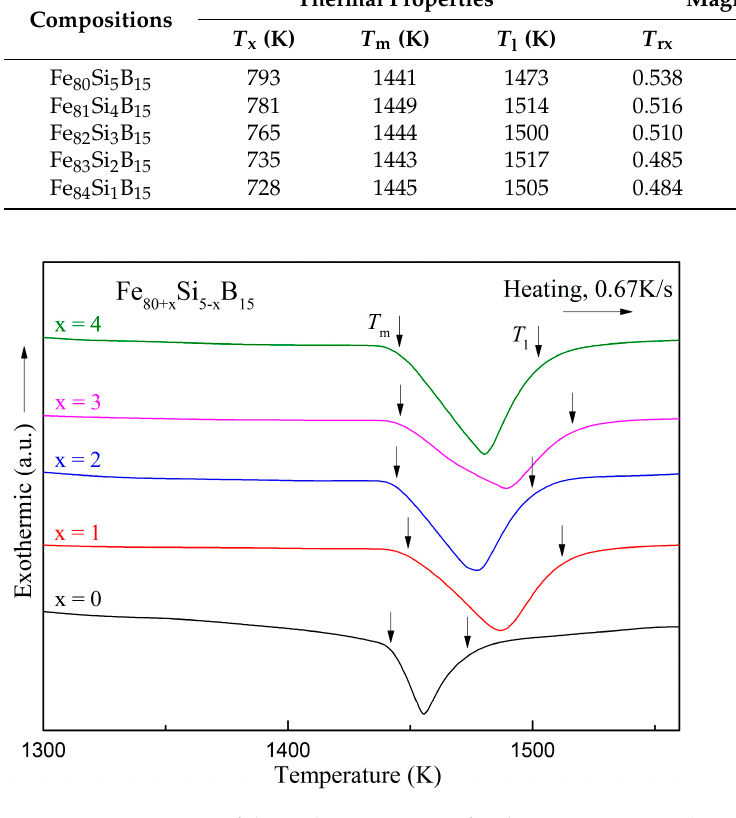
Figure 8. Changes in T rx and H c of the Fe 80+x Si 5 − x B 15 ( x = 0–4) amorphous alloys. The magnetic properties of these glassy alloys were further investigated. The hyste- resis loops of the as-quenched ribbons are presented in Figure 9a. Three individual amor- phous alloy ribbons of each composition, which were prepared at a linear velocity of 35 m/s and polished, were selected for the VSM test to improve the reliability of the data. All samples exhibited the typical loops of soft magnetic amorphous alloys. The B s values were derived from the density ρ (measured by the Archimedean method), the permeability of the vacuum ( μ 0 = 4 π × 10 − 7 N/A 2 ), and the saturated mass magnetization σ s according to the expression B s = μ 0 · σ s · ρ . The results are illustrated in Figure 9b and also tabulated in Table 6. It could be seen that, with an increase of x , the B s values of the amorphous ribbons first increased and then decreased. The maximum B s value of 1.69 T was reached at x = 2 at.%. For the B s of 1.69 T, the content of Si was 3 at.%, the σ s value was 182.5 Am 2 /kg, and ρ was 7.36 × 10 3 kg/m 3 . We noted that for the same sample (3 at.% Si) in the previous literature [46,47], σ s was reported to be 177 Am 2 /kg, with ρ being 7.41 × 10 3 kg/m 3 and, accordingly, the B s value was calculated to be 1.65 T, which was slightly lower than our result (1.69 T). Considering the possible difference in the experiments, including the rib- bon quality and the testing equipment, such a slight variation was considered to be rea- sonable. Overall, our results indicated that when the Fe content was less than 82 at.% in the Fe-Si-B amorphous alloys, the B s value increased with the increase in Fe content and this trend was reversed with a higher Fe content. This observation was in agreement with a previous report [8].